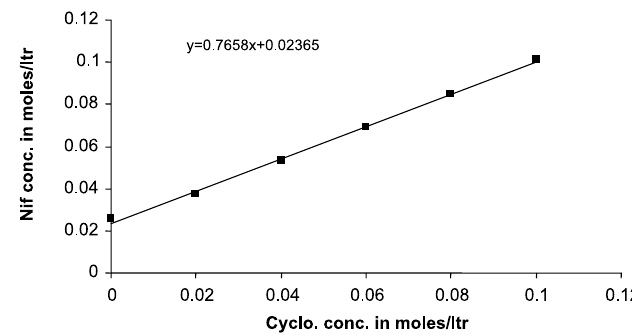
FIGURE 1- Phase solubility analysis plot for inclusion